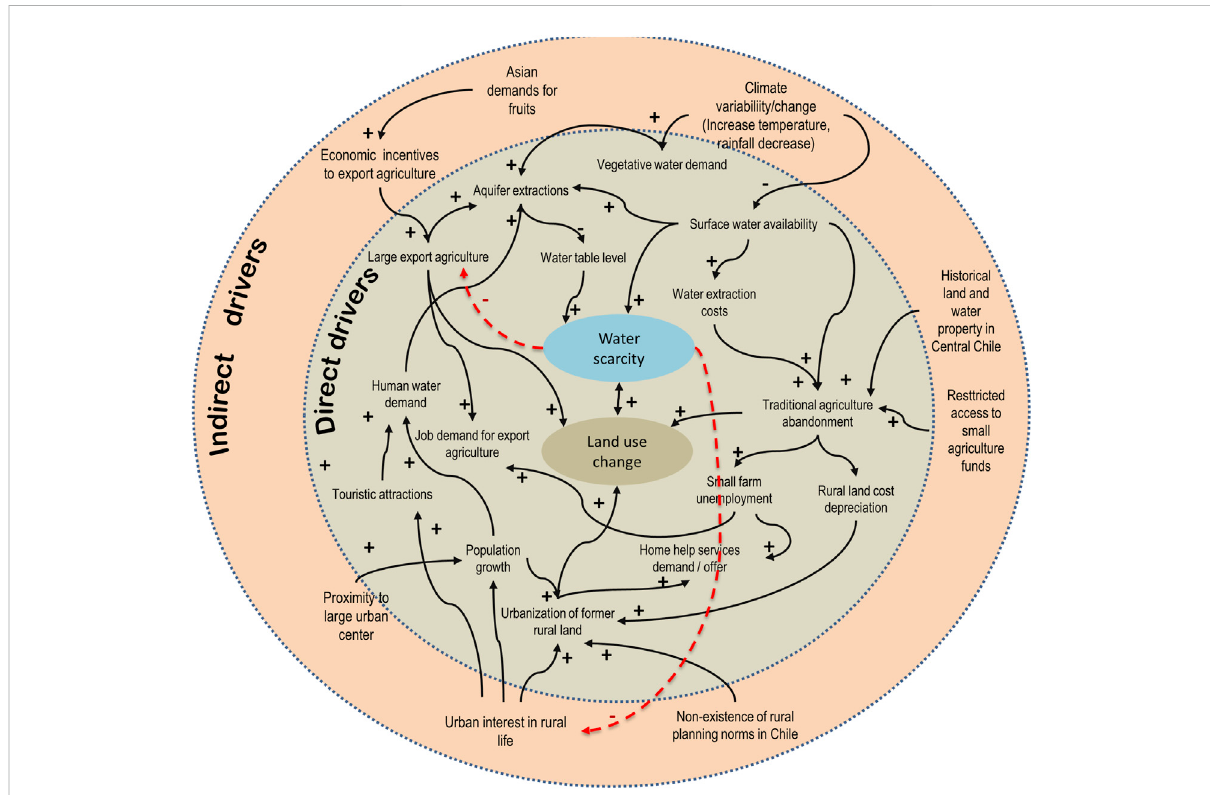
FIGURE 4 Causal loop diagram showing the main in fl uences of internal and indirect external drivers of change, as well as the increasing or decreasing in fl uence on the most important water and land users in the basin (inspired by Butler et al., 2014) 6